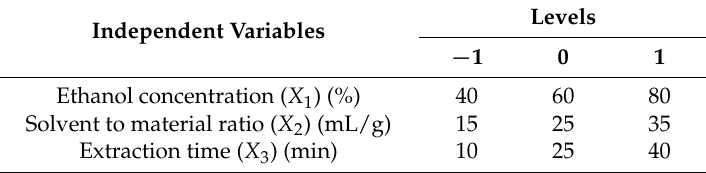
Table 5. Coded and uncoded levels of the independent variables used for the Box–Behnken